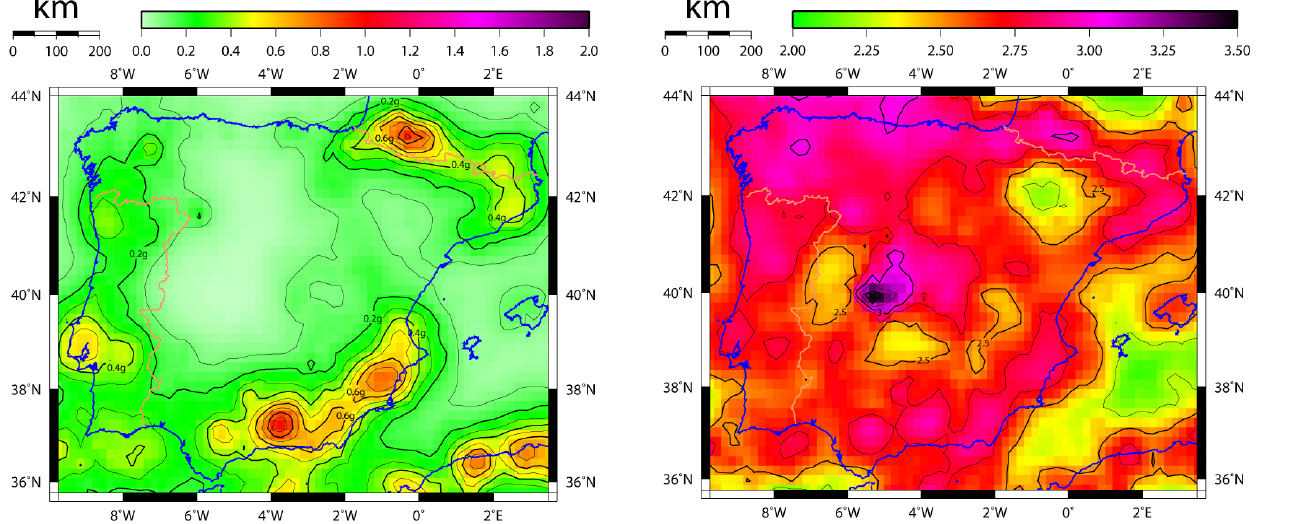
Figure 11. Distribution of the accelerations obtained for T = 0 . 1s and 475yr return period.